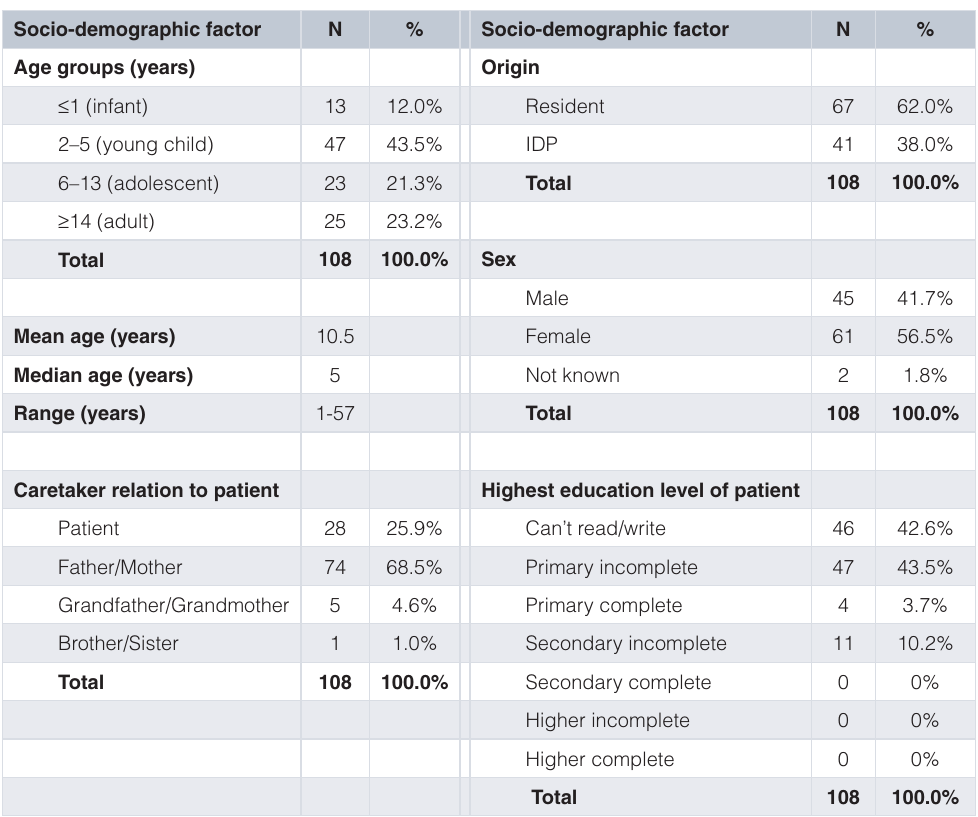
Table 3. Socio-demographic description of the study population (patients and